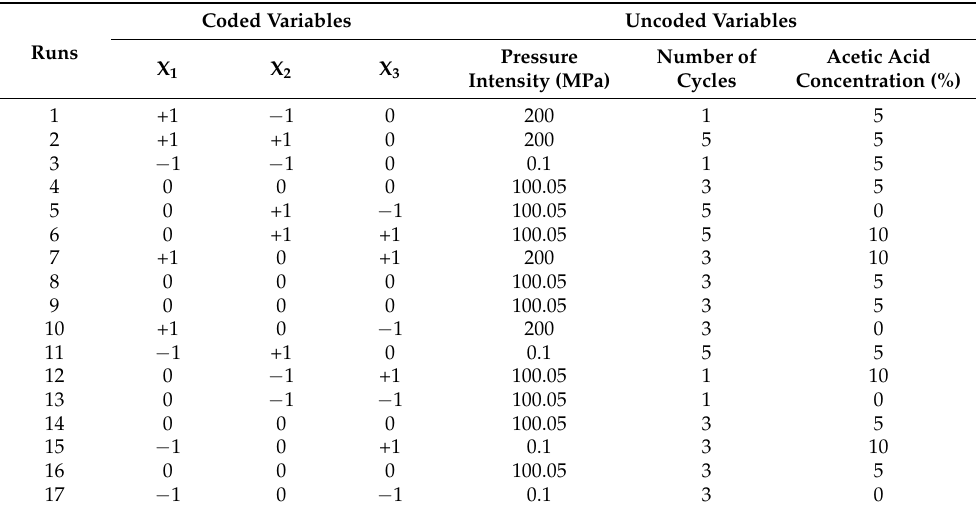
Table 1. Experimental design, including process variables and their levels expressed in terms of coded and uncoded